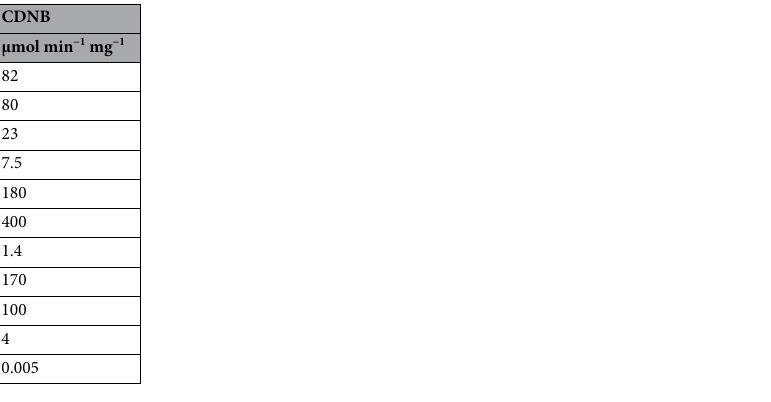
Table 1. Specific activities of human GSTs with JS-K and CDNB. Assays were made spectrophotometrically at 30 °C and pH 7.5 with 50 µM JS-K and 1 mM GSH. All measurements were made in triplicate and values are means, corrected for background reaction, ± S.D. (standard deviation); Nd (no detectable activity). The CDNB activities (at pH 6.5) have previously been reported 19